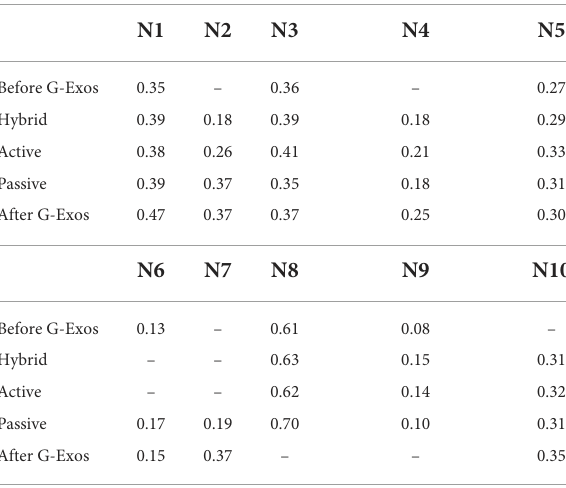
TABLE 3 Speed in m/s when walking.